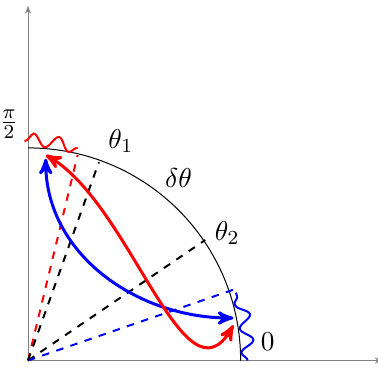
Figure 24 . Bulk e(cid:11)ective representation of connectivity in terms of the (cid:18) angle measuring the 3-cycles in the